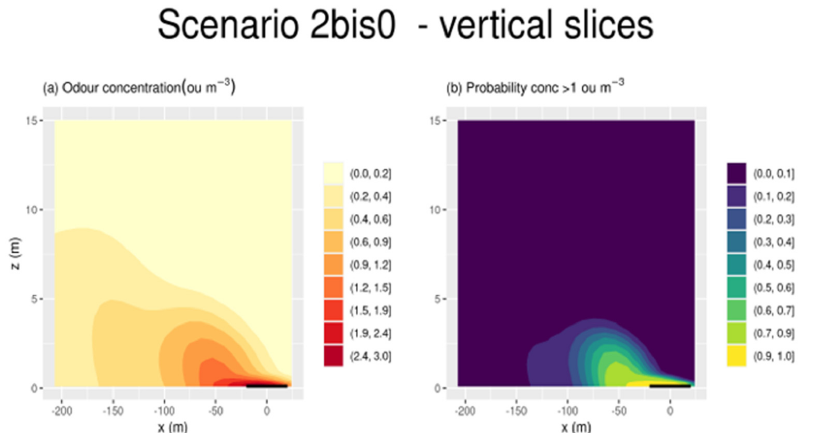
Figure 13. Vertical slices (x–z directions) of the odour concentrations ( a ) and exceedance probability of the 1 ou m − 3 threshold ( b ) from the ground up to a 15 m height as simulated by SCICHEM. The meteorology and total emissions are the same as in the wind gust episode of scenario 2, but with the emission field replaced by a 40 m − diameter circular source, represented by a horizontal black line in the graphs. The coordinate x is expressed as the distance in meters from the center of the source, and z as the height in meters above the ground.